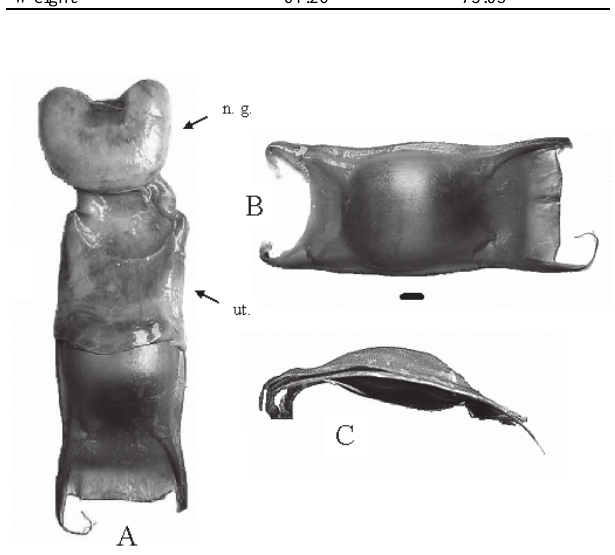
Fig. 5. (A) A fresh single posterior (left) oviduct of 92.0 cm female of Dipturus chilensis ; n. g.=nidamental gland; ut.=uterus (posterior end, toward the nidamental gland). (B) The term egg capsule of Dipturus chilensis in upper view (same capsule as in A). (C) Lateral view of a fixed egg capsule of Dipturus chilensis (same capsule as in A and B). Black bar represents 1 cm in B and C. In B and C, anterior end to the left and posterior end to the